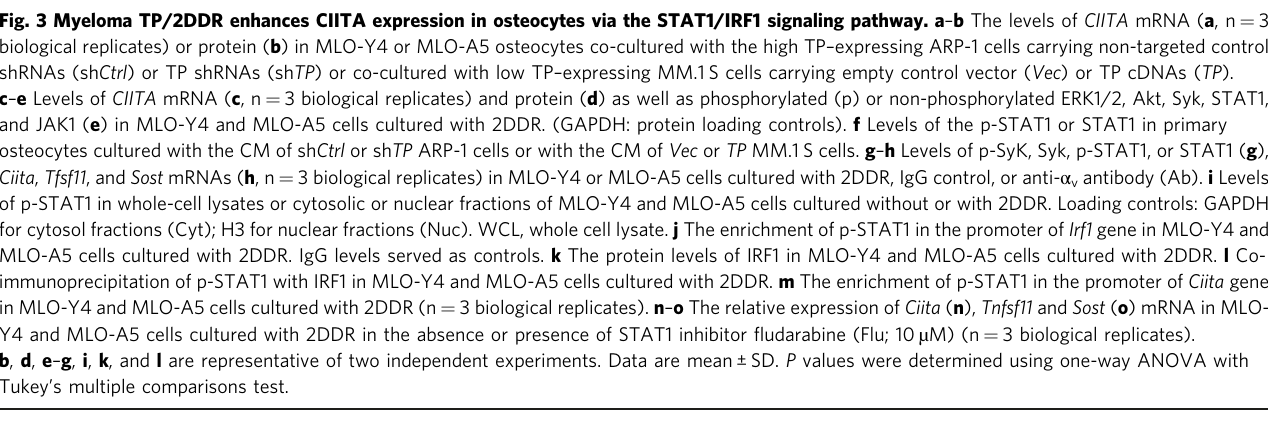
Fig. 3 Myeloma TP/2DDR enhances CIITA expression in osteocytes via the STAT1/IRF1 signaling pathway. a – b The levels of CIITA mRNA ( a , n =